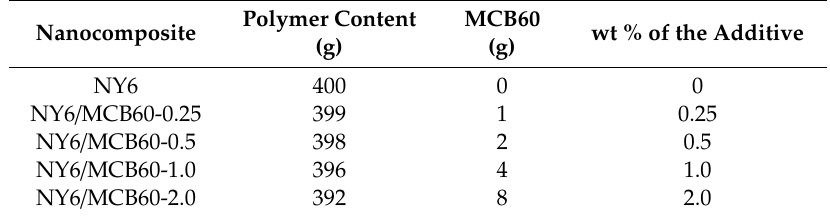
Table 2. Quantity and Identification of the nanocomposites